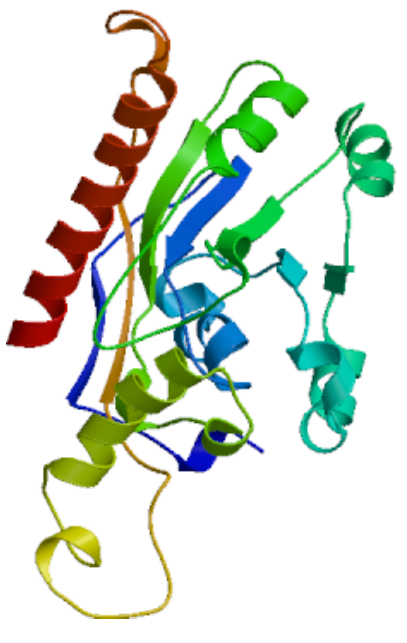
Figure 7. Deduced tertiary structure of buffalo DGAT2.